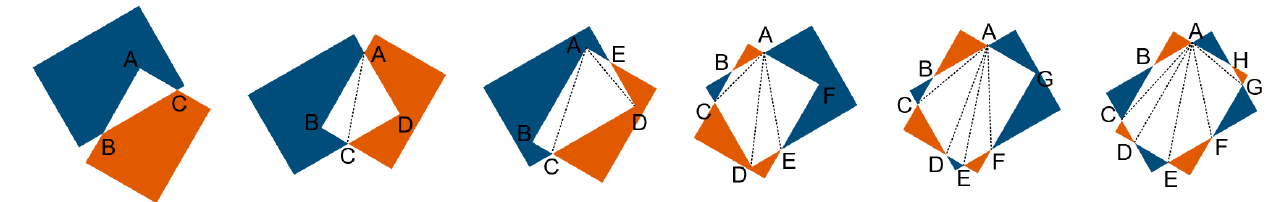
Figure 7. The Intersection over Union (IoU) of bounding boxes. Algorithm 1 Skew IoU computation